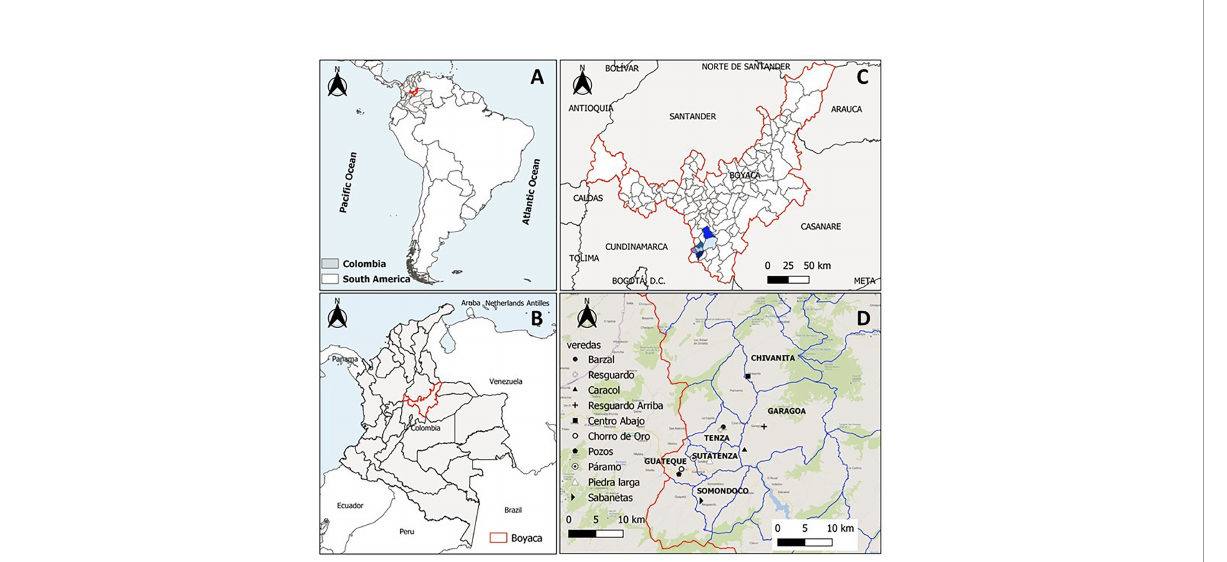
FIGURE 1 Geographical distribution of the samples in the study area and collection sites. (A) Map of south America highlighting Colombia, (B) Map of Colombia highlighting Boyaca ́ , (C) Map of Boyaca ́ highlighting the study area and (D) Municipalities of Valle de Tenza and villages